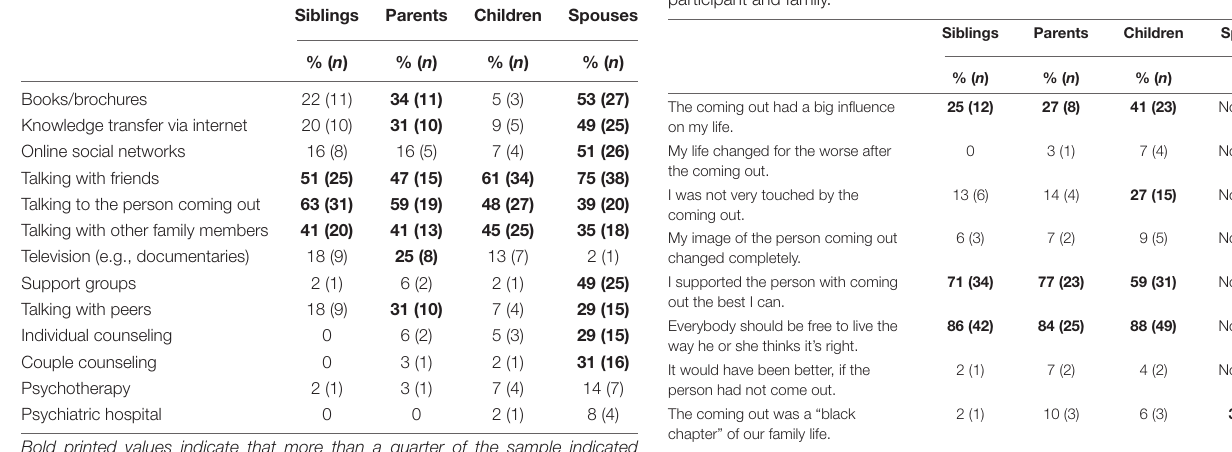
TABLE 7 | Use of support options. TABLE 8 | Thoughts about the coming out and its impact on the participant and